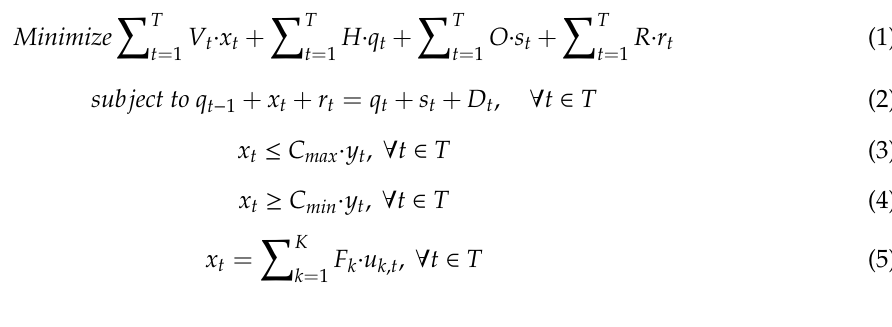
Table 1. Notations for Mathematical Model.